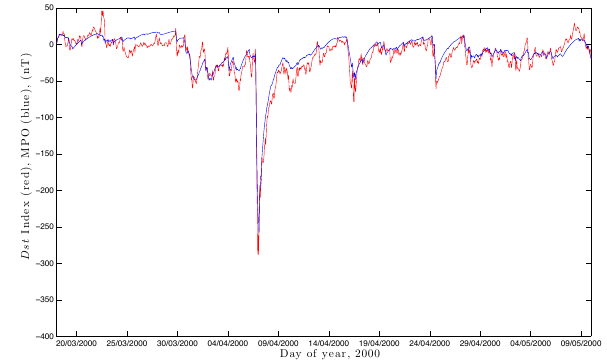
Fig. 2. The model predicted output in blue and the measured Dst index in red between March and May